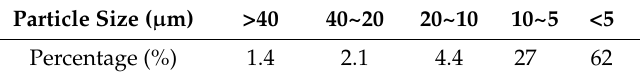
Table 3. Particle size distribution of diatomite.